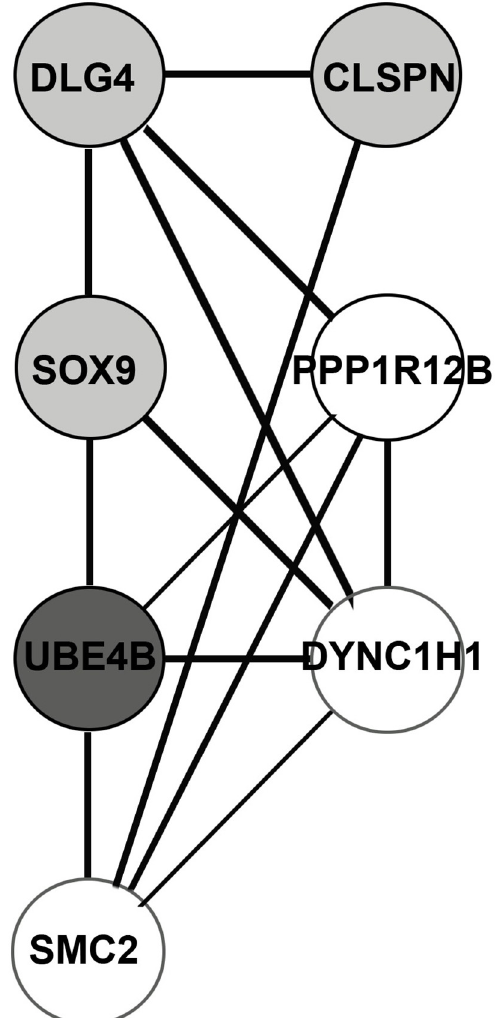
Fig 3. Network of cluster centres of stage-II network. Clustering was done using